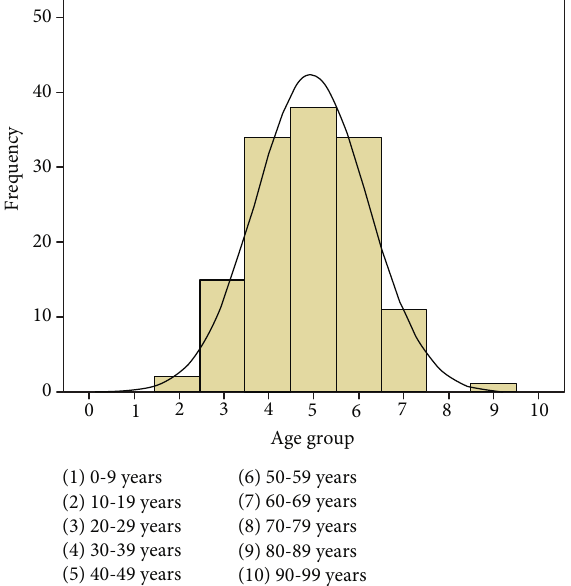
Figure 1: Age group distribution of the study population.